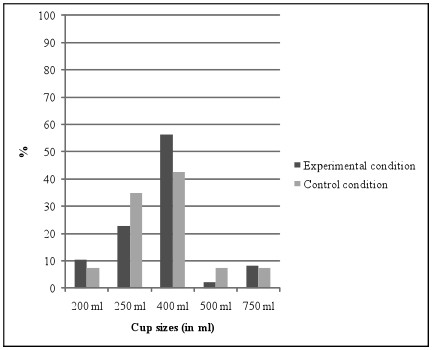
Cup size choices (in %) in both study conditions1. 1χ2 (4) = 3.58, p = .47.